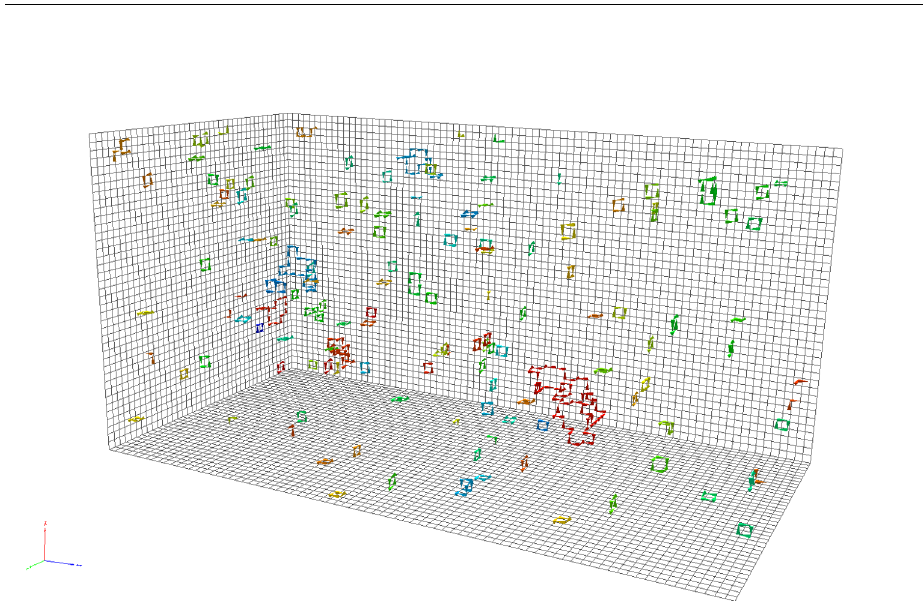
Figure 5. The centre-vortex structure of the secondary loops identified from the dynamical-fermion configuration shown in figure 3. ( Click to activate.